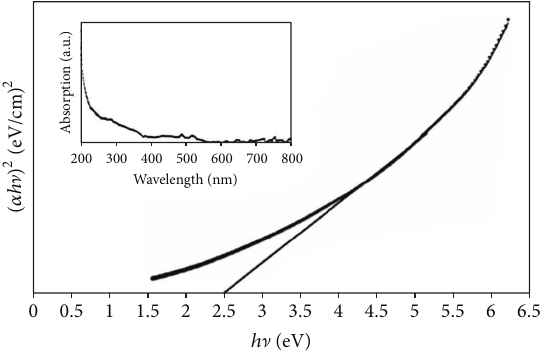
Figure 3: Band gap calculations for BFO nanofibers revealed the band gap energy of 2.5 eV. The inset shows the absorbance of the nanofibers for the irradiation by the light in a range of 200–800 nm.